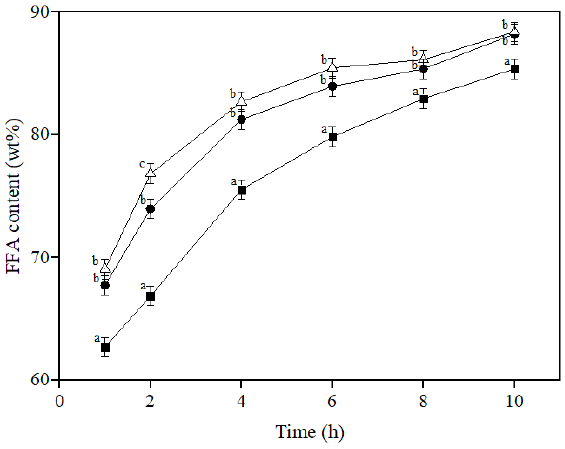
Figure 2. Effect of catalyst percentage ( 5 wt%, 10 wt% and 15 wt% based on the substrates mass) on the FFA content (reactions performed at 55 °C, 50 wt% buffer solution, and stirring rate of 400 rpm). Means followed by the same letter, for the same reaction time, do not statistically differ